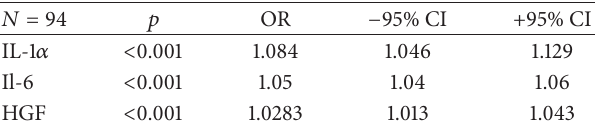
Table 6: Univariate logistic regression analysis of the risk of liver cirrhosis depending on the level of IL-1 𝛼 , Il-6, and HGF.